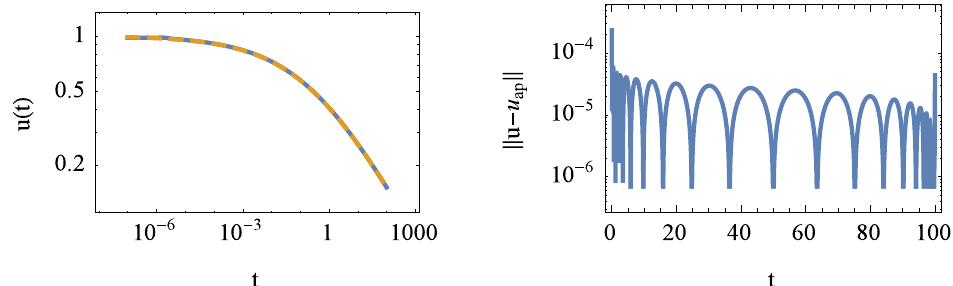
Figure 12. Solution of the fractional relaxation Equation (87) generated by the direct inverse Laplace transform of G ( s ) . The left panel also includes the exact solution of the fractional relaxation equation given by u ( t ) = u Mittag-Leffler function. The right panel shows the local error between the exact solution and the approximation. The number of approximation points used in the calculation was m = 2 n + 1 = 65 . The parameters to generate the plot are u The numeric terms are due to the scaling given in time steps of months.